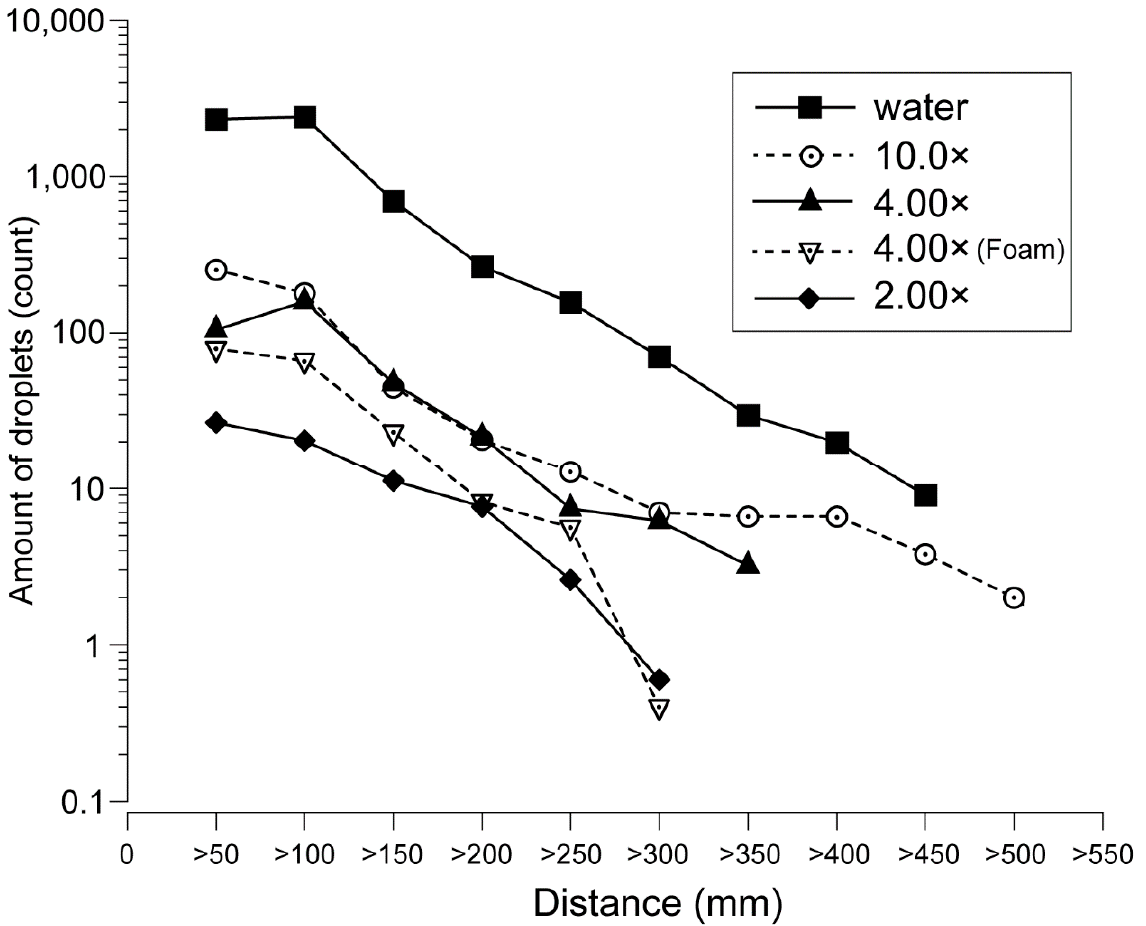
Figure 5. Comparison of the number of droplets within the flight distance range for each toothpaste dilution ratio. The black square indicated dentifrice with water. White circles: 10% (10.0×); black triangles: 25% (4.00×); white inverted triangles: 25% (4.00×, form); black diamonds: 50% (2.00×). The logarithmic value of the number of droplets is shown on the vertical axis and the flight distance range is shown on the horizontal axis. At all dilution concentrations except 1.00×, the number of droplets within the range tended to decrease as the distance from the droplet generating portion increased.